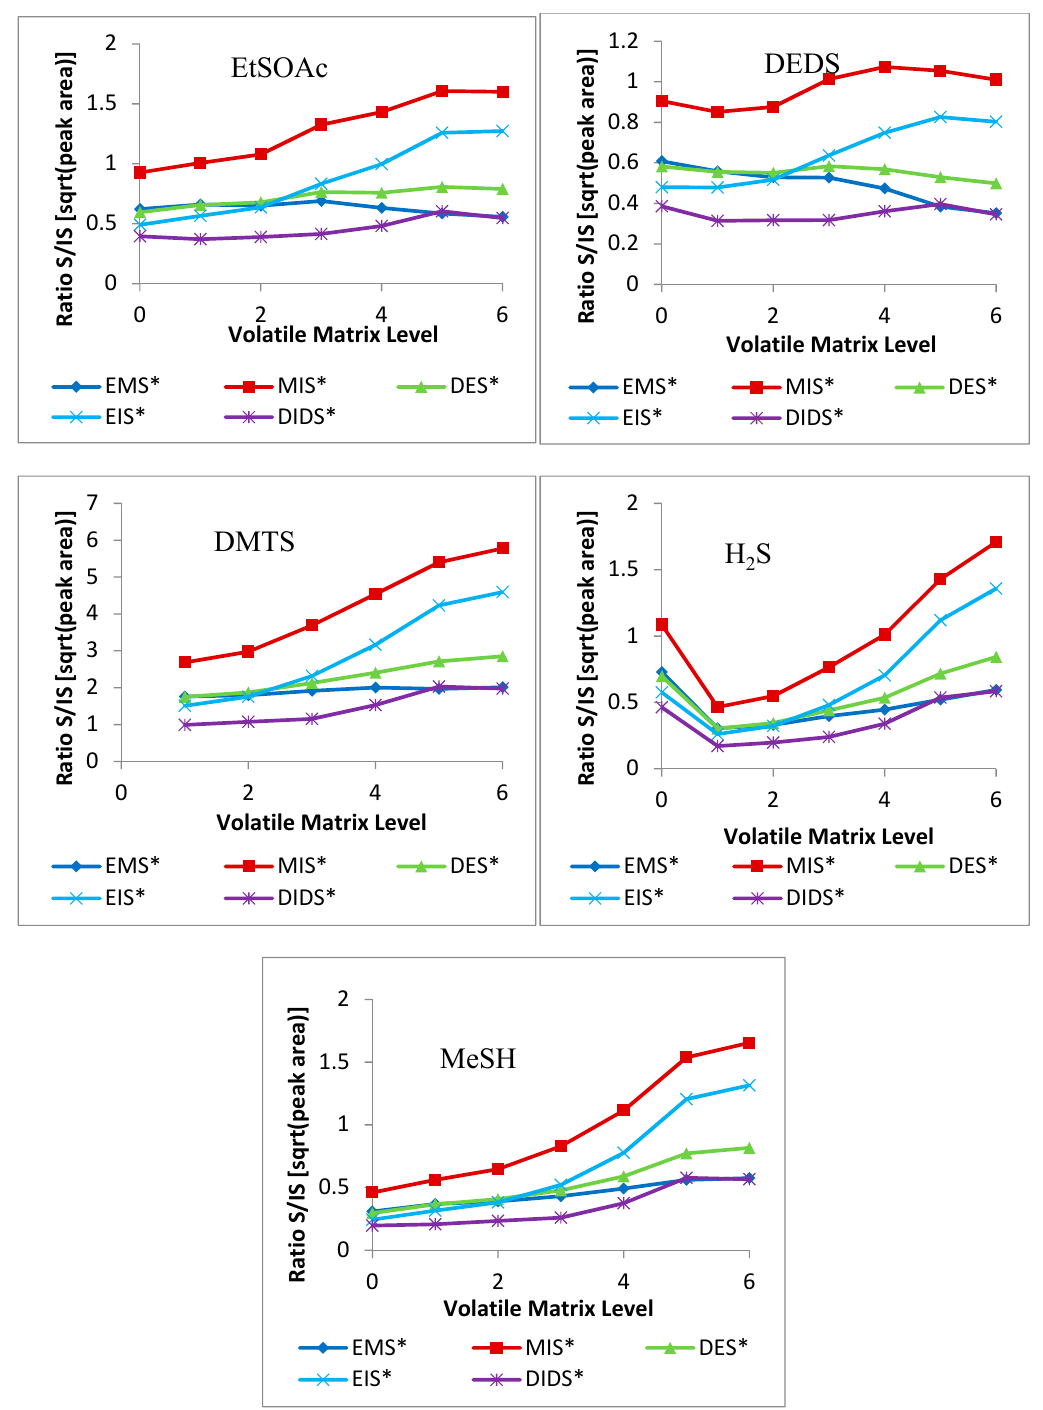
Figure 5. Effect of volatile matrix on analyte-to-internal-standard ratios against all five internal standards of DMS, MeSOAc, EtSOAc, DEDS, DMTS, H 2 S, and MeSH.